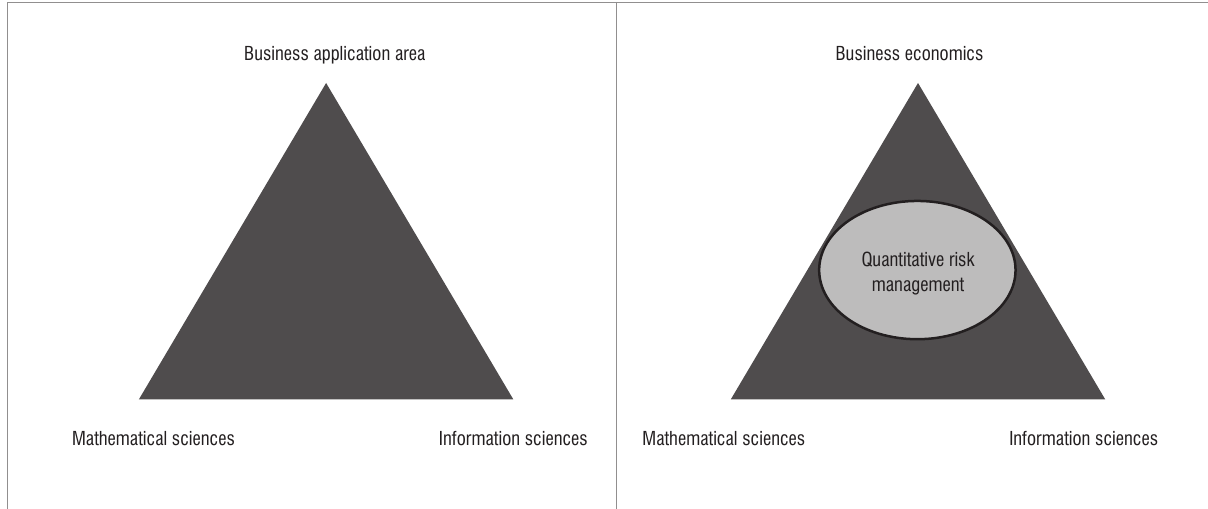
(a) The BMI Triangle and (b) our focused BMI